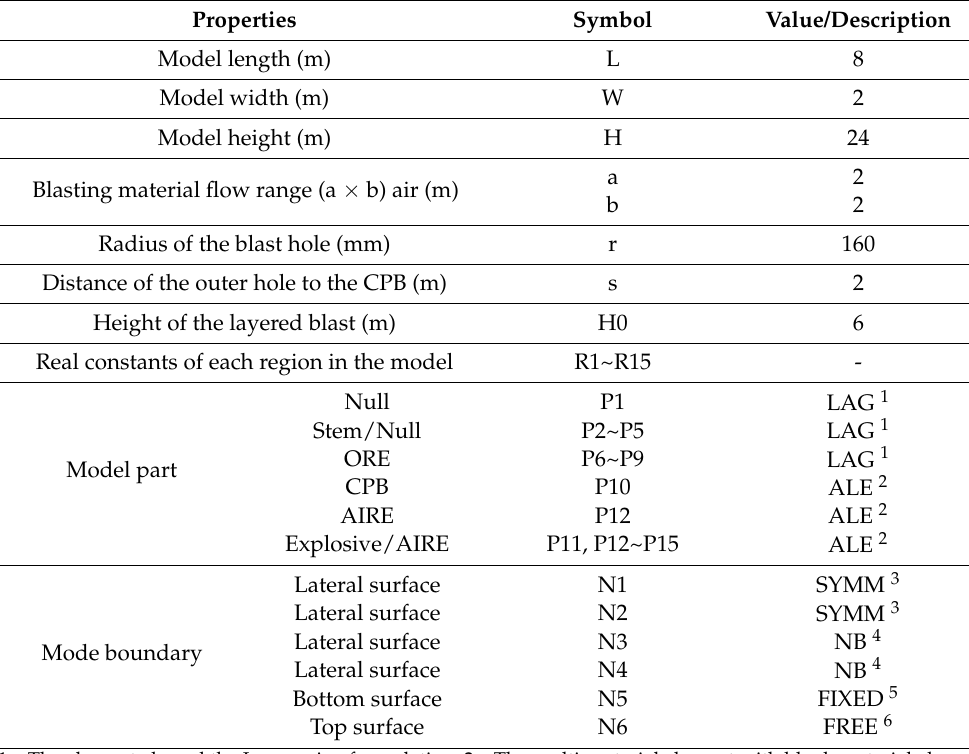
Table 1. Geometric model parameter for the lift